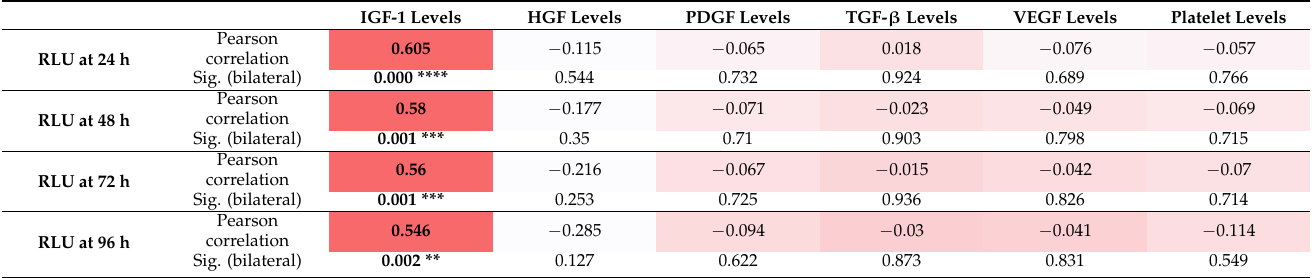
Table 2. Correlations between growth factors and cellular viability levels represented in RLU.